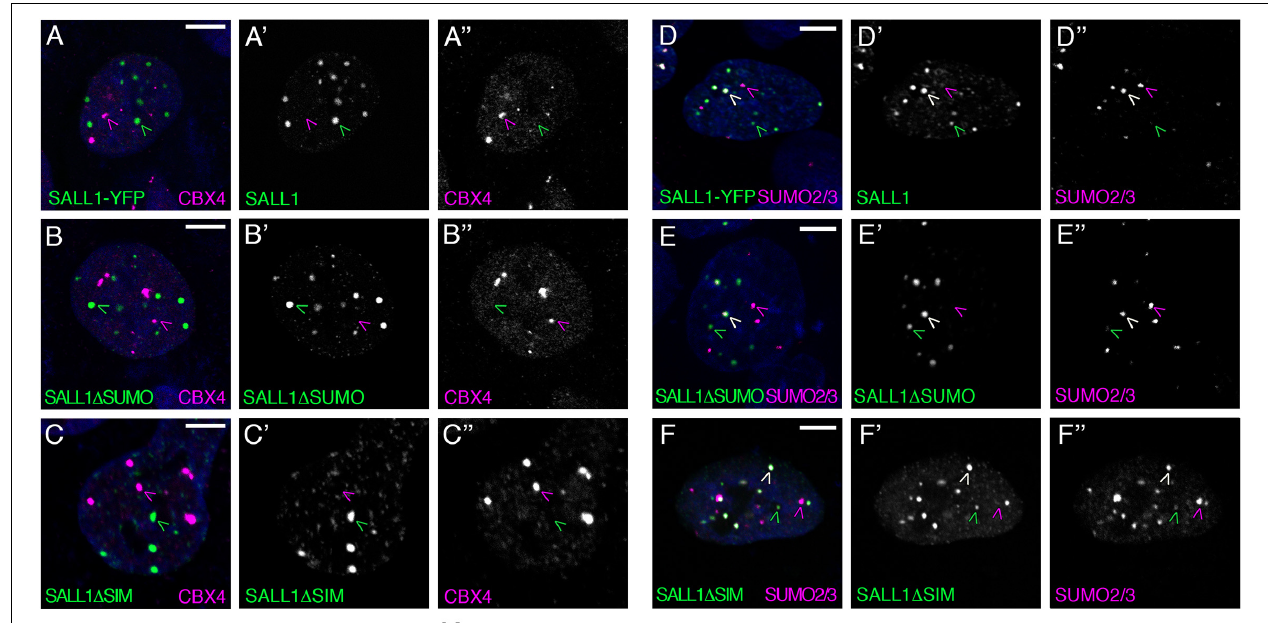
FIGURE 1 | SALL1 and CBX4 do not colocalize in nuclear bodies. (A–F) Confocal images of U2OS cells showing expression of SALL1-YFP, SALL1 (cid:49) SUMO-YFP, or SALL1 (cid:49) SIM-YFP (green), and endogenous CBX4 (magenta in A–C ) or endogenous SUMO2/3 (magenta in D–F ). Nuclei were stained with DAPI. Black and white pictures show single green or magenta channels. Green arrowheads indicate SALL1 bodies, magenta arrowheads indicate Pc bodies (A–C) , or SUMO bodies (D–F) and white arrowheads indicate colocalization of SALL1 and SUMO2/3 (D–F) . Pictures were taken with a Leica DM IRE2 confocal microscope using a 63 × objective. Scale bars indicate 5 µ